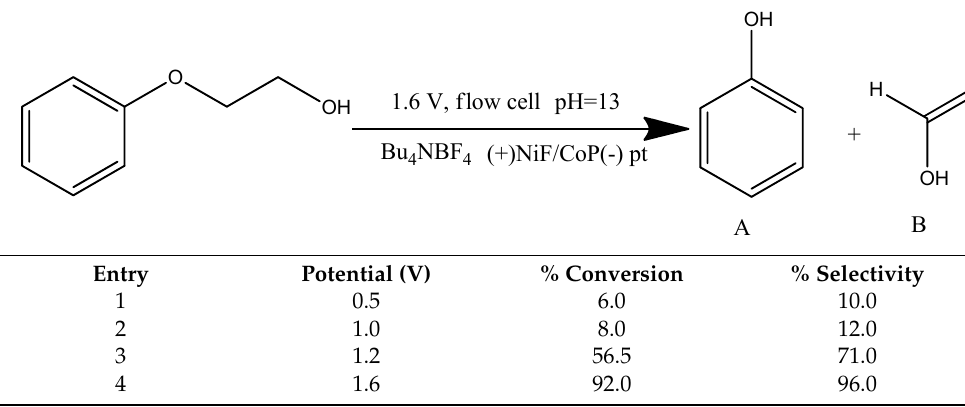
Molecules 2022 , 27 , x FOR PEER REVIEW 7 of Table 2. Optimization of droplet-assisted electrochemical oxidation of 2-phenoxyethanol *.